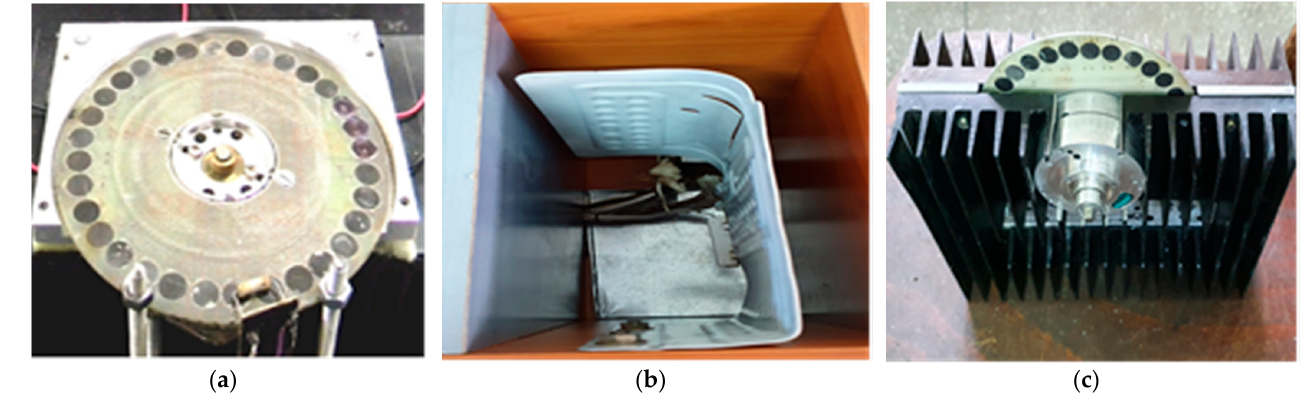
Figure 6. Experimental gadolinium motor stand—variant 1: ( a )—rotor with gadolinium pills and heating resistors; ( b )—cooling system; ( c )—general view [1,25].